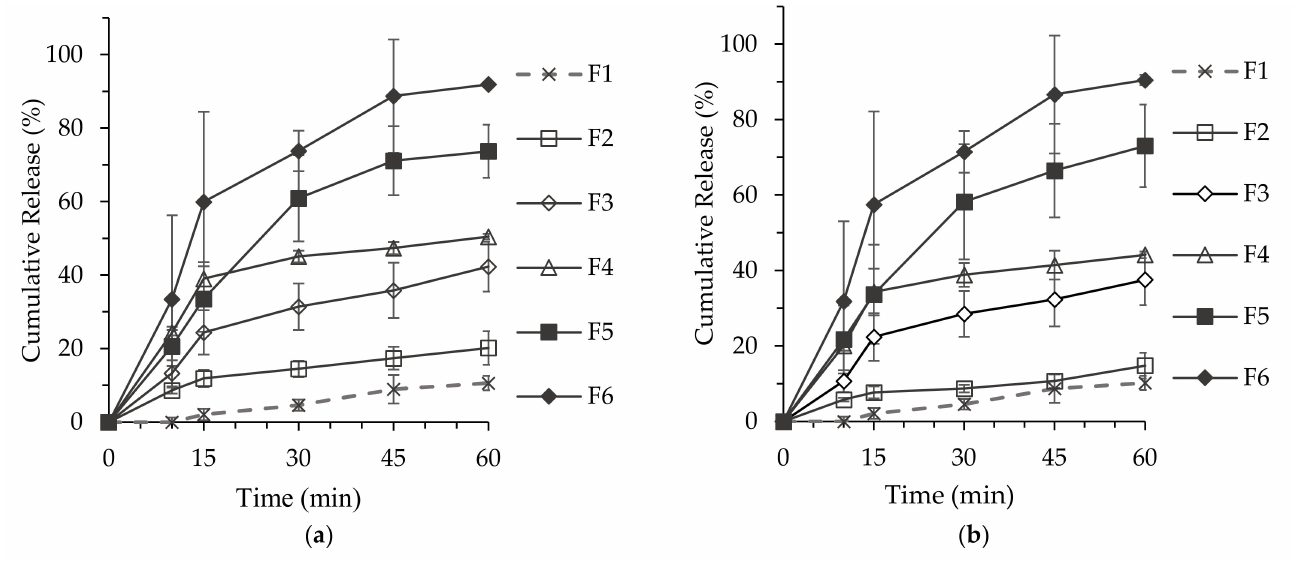
Figure 5. Dissolution of Ω -3 fatty acids: oleic acid: phospholipids vs Ω -3 acid ethyl esters. ( n = 3), ( a ) In vitro dissolution rate of the EPA (eicosapentaenoic acid) from F1–F6; ( b ) In vitro dissolution rate of the DHA (docosahexaenoic acid) from